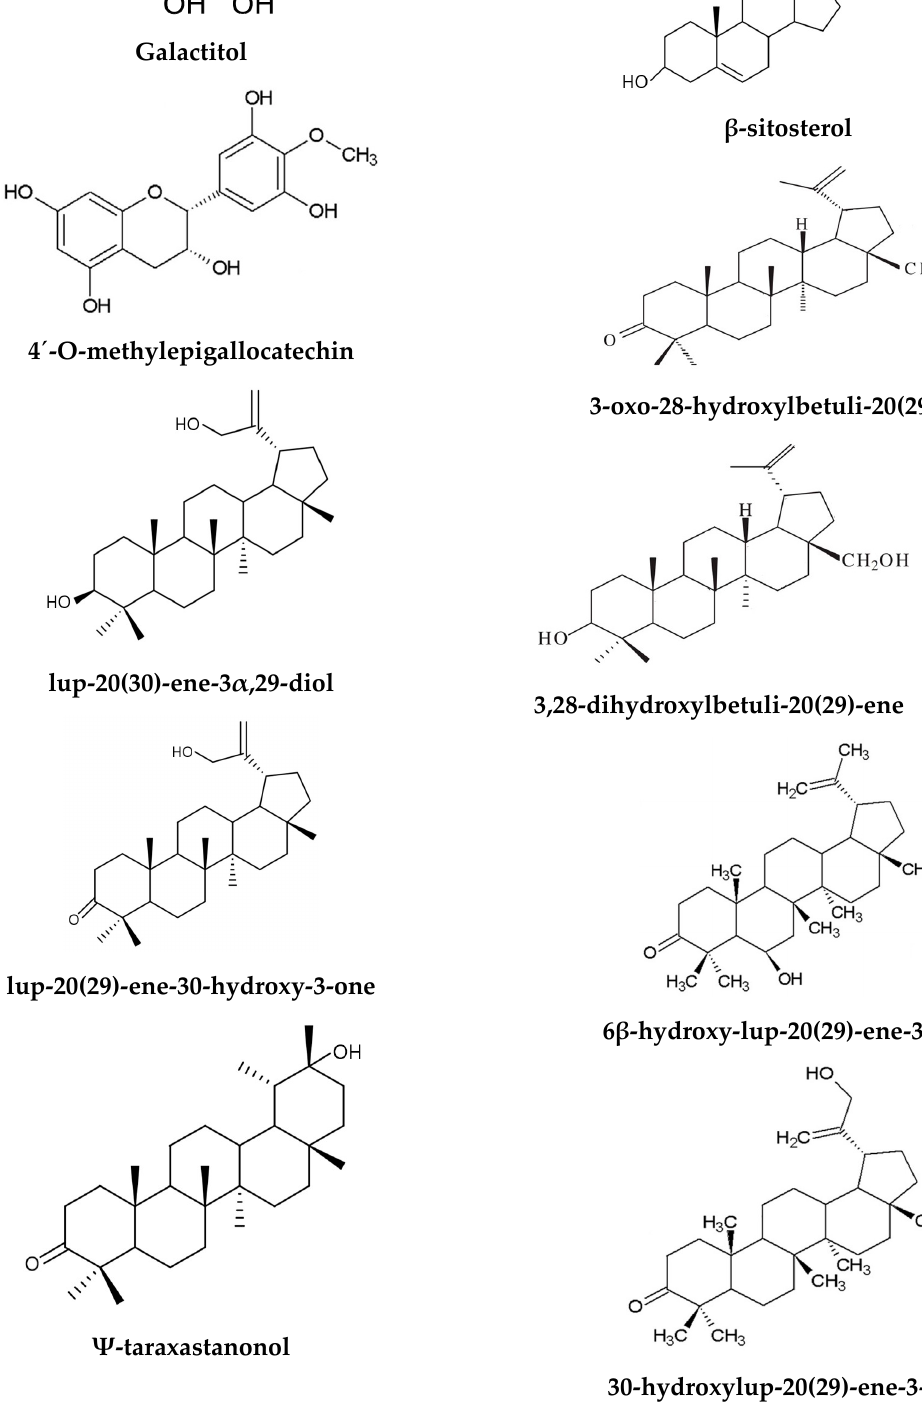
Figure 1. Chemical structures of compounds isolated from Elaeodendron transvaalense.